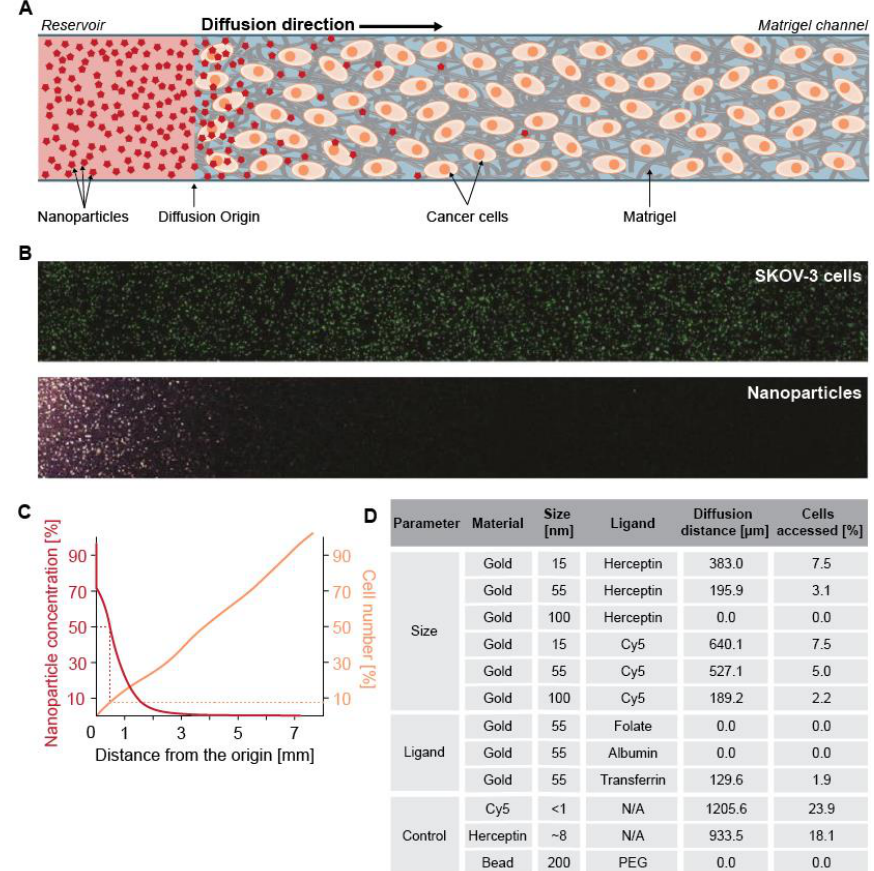
Figure 5. ( A ) Scheme of nanoparticle diffusion in 3D SKOV-3 cells (ovarian cancer cell line)